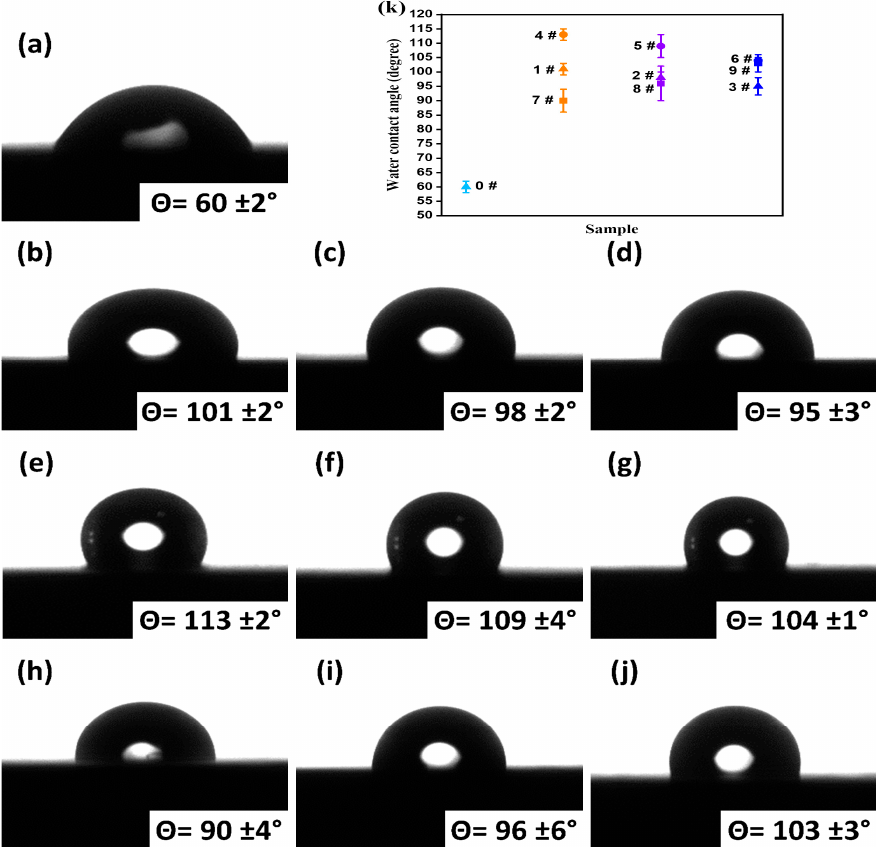
Figure 7. Water contact angle of ( a ) AlZr; ( b ) Al 2 O 3 /AlZr; ( c ) ZnO/AlZr; ( d ) TiO 2 /AlZr; ( e ) AlZr/Al 2 O 3 ; ( f ) AlZr/ZnO; ( g ) AlZr/TiO 2 ; ( h ) AlZr/Al 2 O 3 /AlZr; ( i ) AlZr/ZnO/AlZr; and ( j ) AlZr/TiO 2 /AlZr. ( k ) The variation of the water contact angles of the coatings. The error bar belongs to standard deviation.